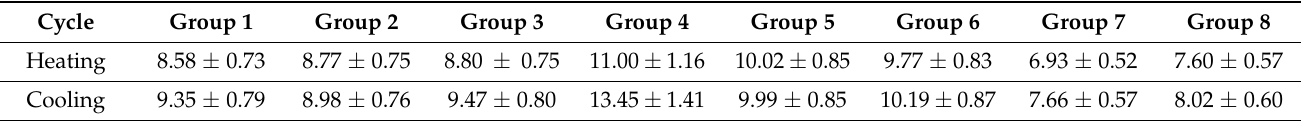
Table 6. Values of coefficient A for heating and cooling